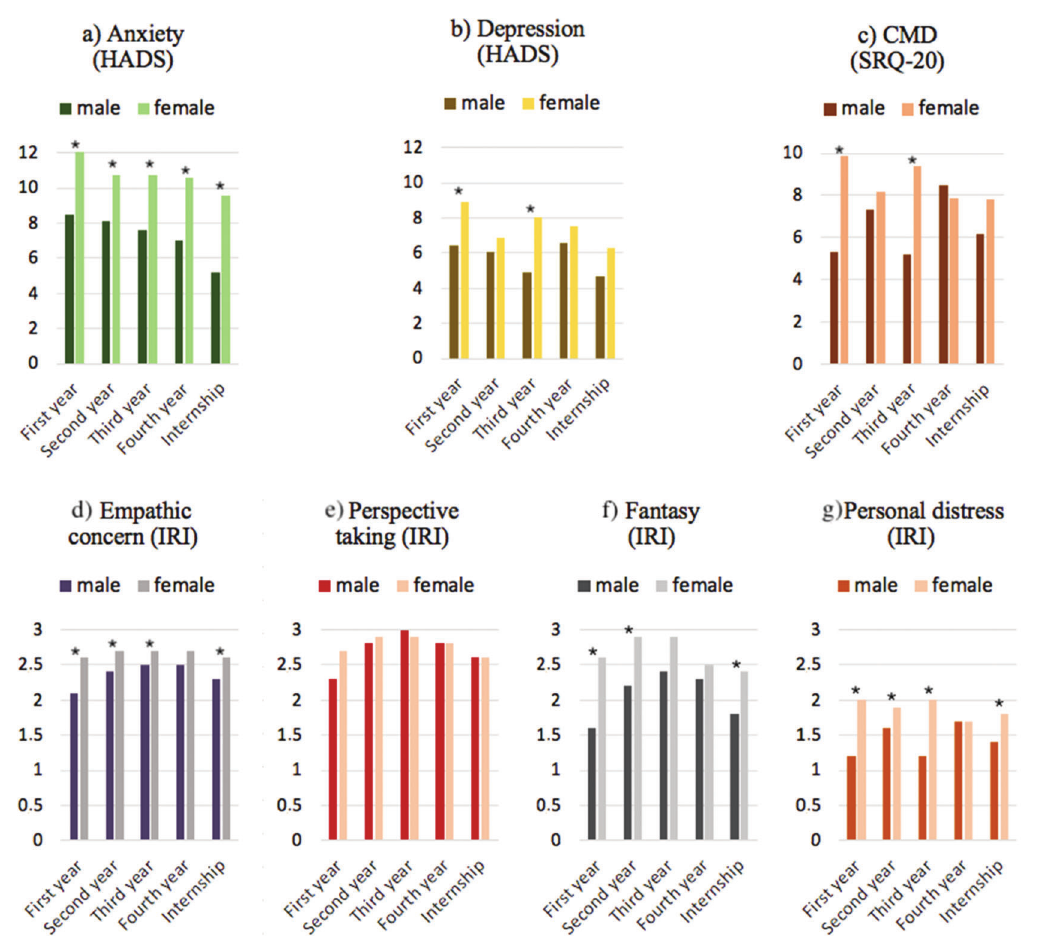
Figure 1 - Comparison of mental health indices across the years and among genders. Note : SQR-20: self-reporting questionnaire with 20 items; HADS: The Hospital Anxiety and Depression Scale of Anxiety; IRI: Interpersonal Reactivity Index; Internship: clerkship, completed in the same institution. (*) p p 0.05 in Mann-Whitney test comparing male and female groups in each year year-class